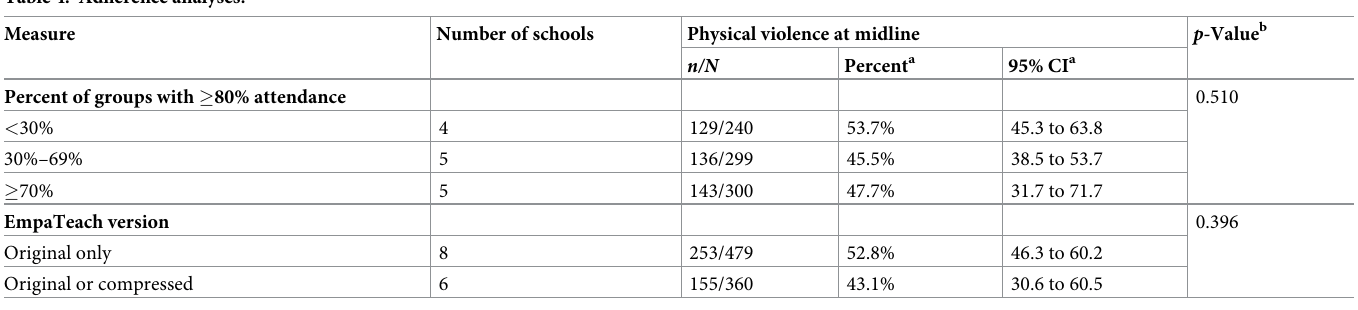
Table 4. Adherence